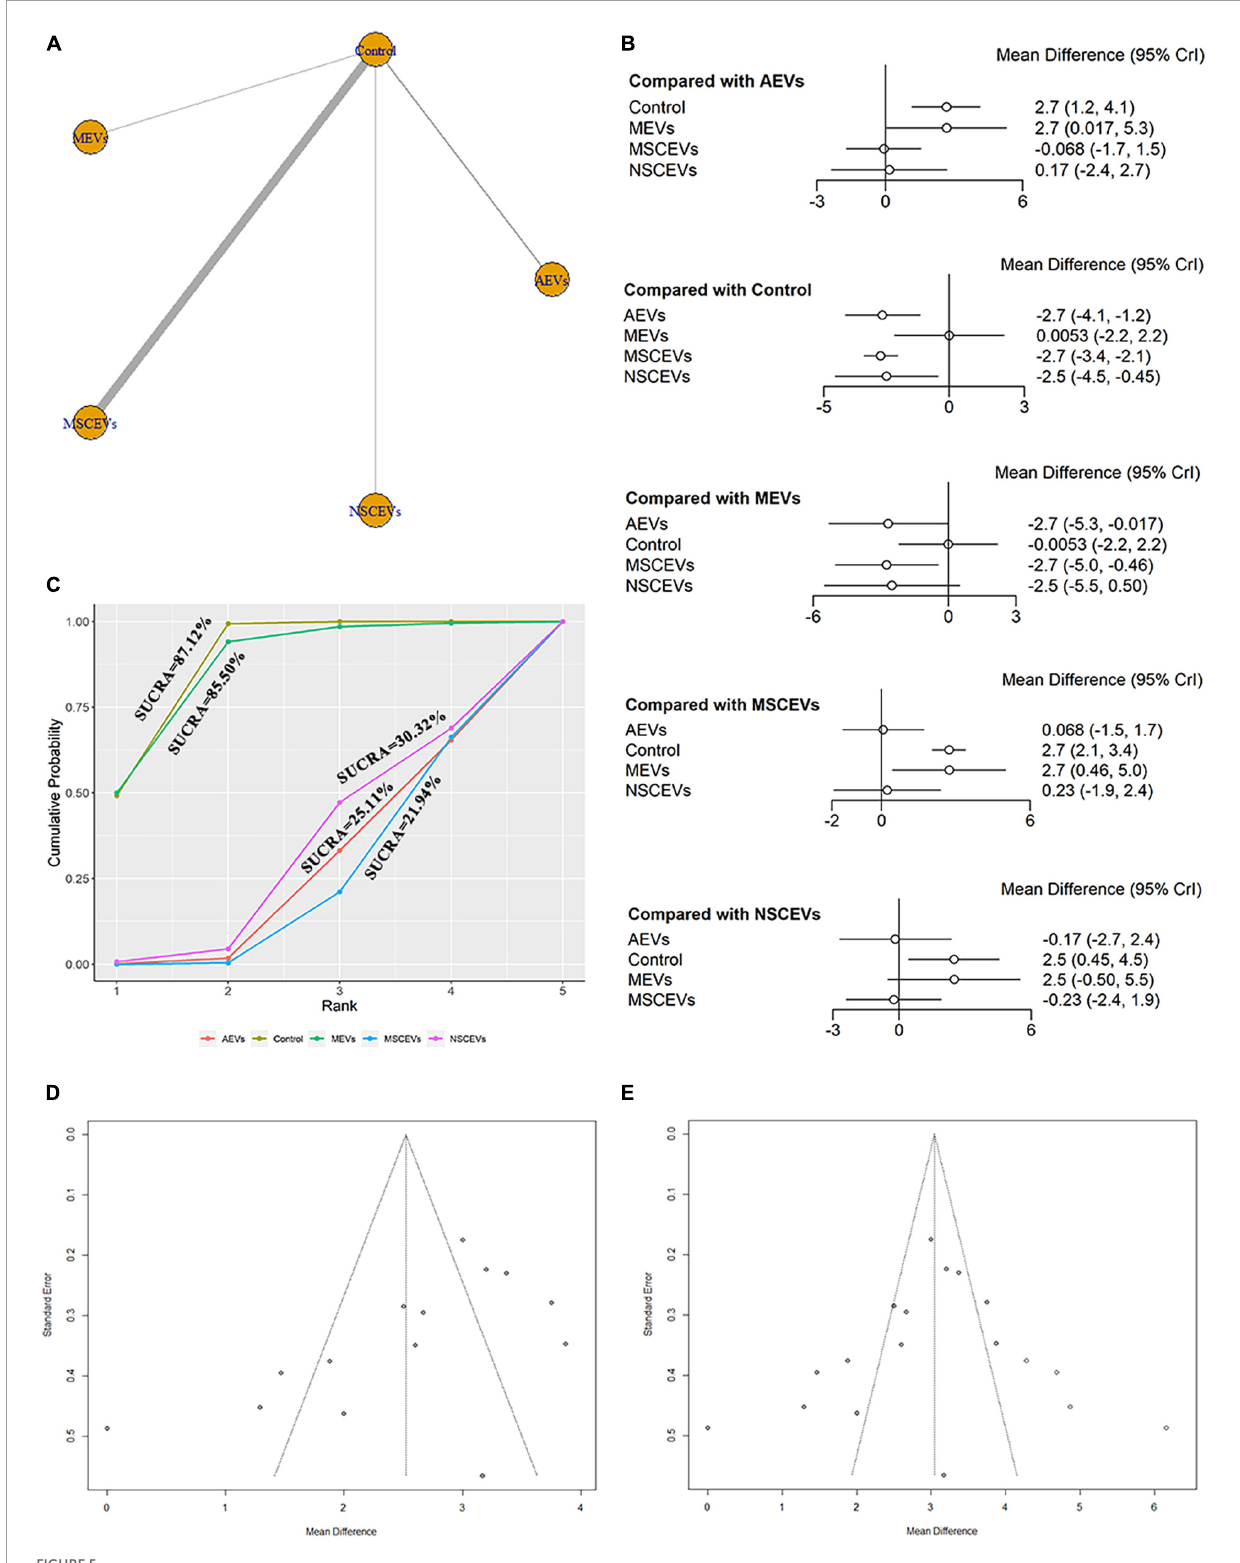
FIGURE5 Comparison of the efficacy of extracellular vesicles (EVs) from different cell sources in modified Neurological Severity Score (mNSS) at day 14 post-traumatic brain injury (TBI). (A) Network plot; (B) Forest plot; (C) Surface under the cumulative ranking curves (SUCRA); (D) Funnel plot; (E) Funnel plot by the trim and fill analysis method. The dotted lines represent 95% confidence interval (95% CI). AEVs, astrocyte-derived extracellular vesicles; MEVs, microglia-derived extracellular vesicles; MSCEVs, mesenchymal stem cell-derived extracellular vesicles; NSCEVs, neural stem cell-derived extracellular